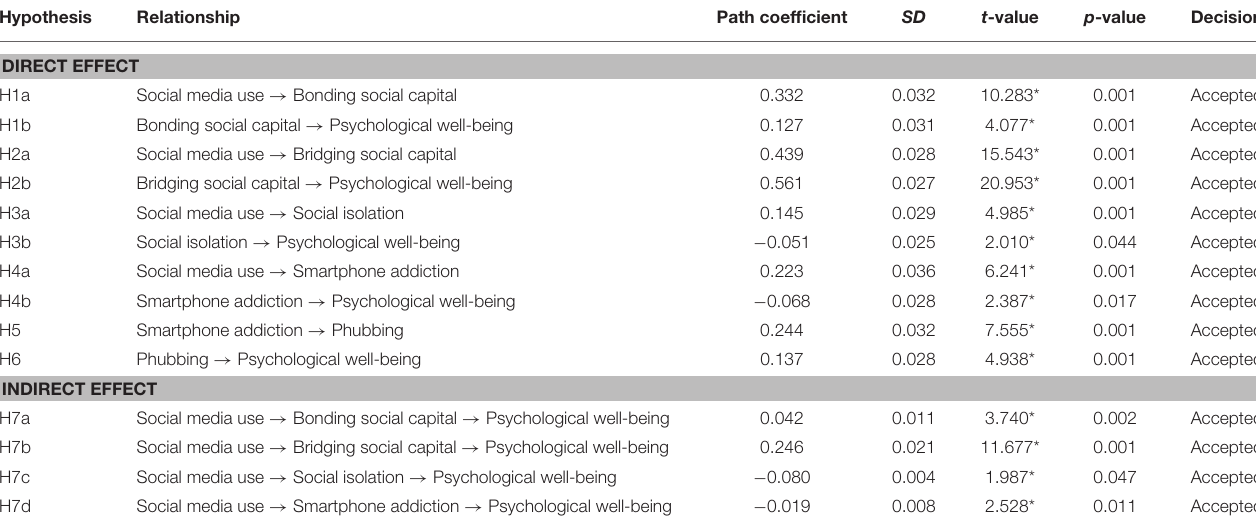
TABLE 5 | Summary of path coefficients and hypothesis testing.